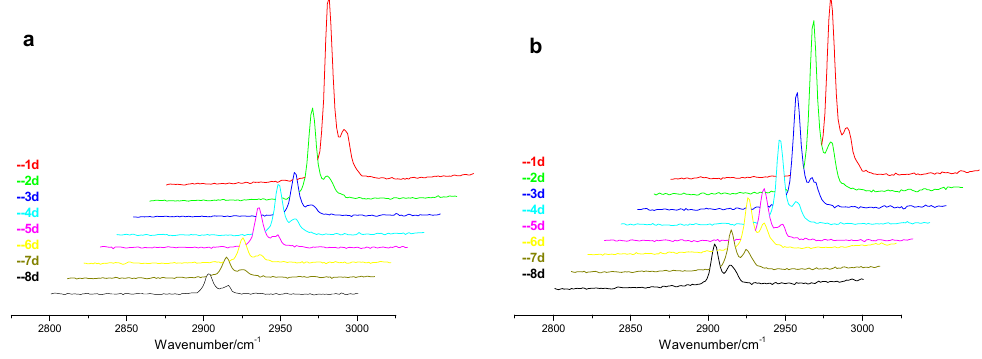
Figure 6. The Raman spectroscopy change of CH 4 hydrate at point “A” for experiment 1 ( a ) and experiment 2 ( b ), where the 1d, 2d, 8d represent the first, the second, the eighth day of the experiment process.